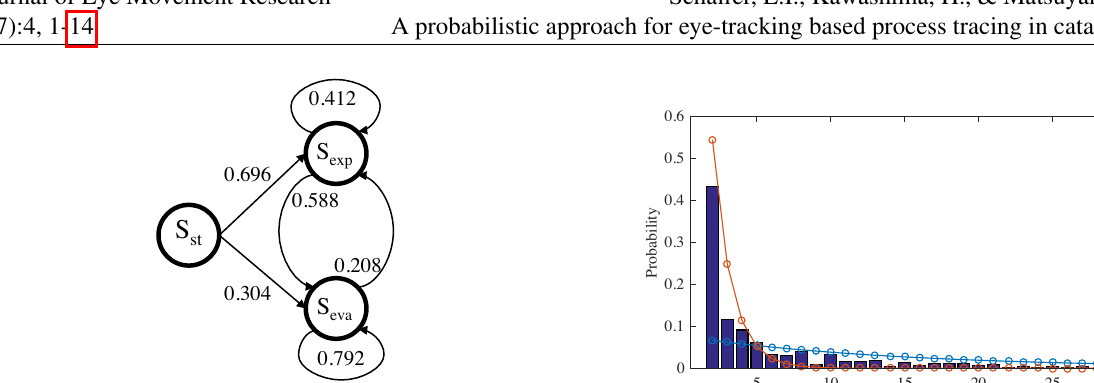
Figure 5 . The estimated transition probabilities of the brows- ing states using eye tracking data of all participants.